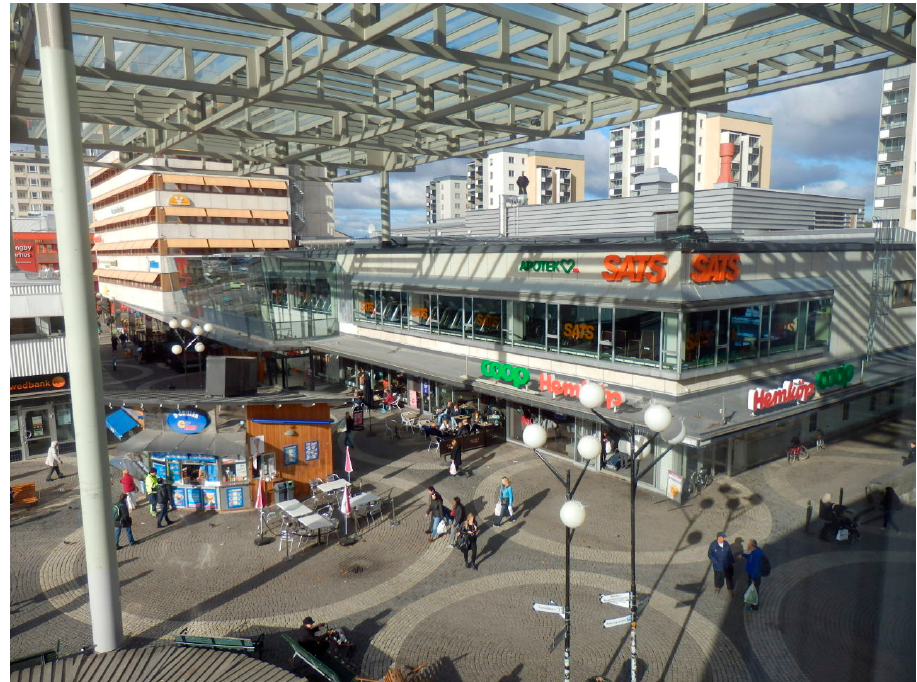
Figure 29. Vällingby: The original transit-oriented new town in Stockholm built over the tunnelbana. Source: Jeffrey Kenworthy.